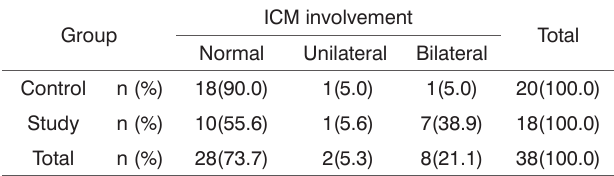
Table 1. Distribution of the Control and Study Groups, in ab- solute (n) and relative (%) values in relation to a disorder in the SSI test with ICM in the intensity between 0 and -10